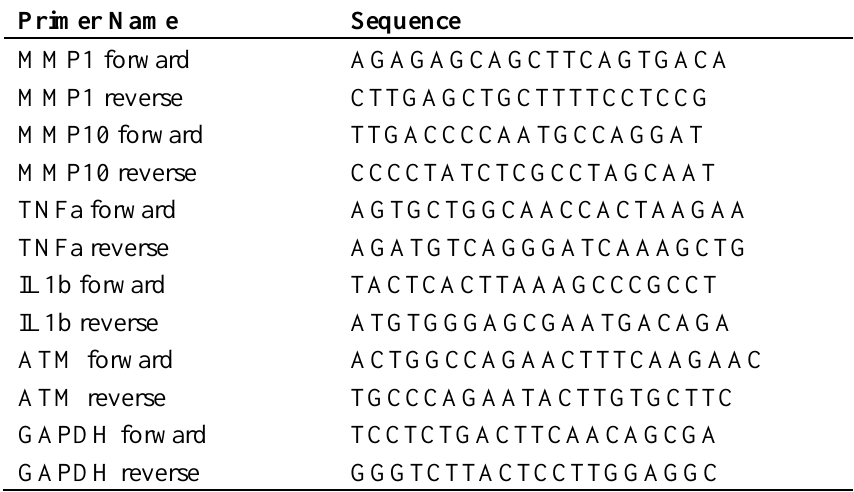
Table 1. Primers for